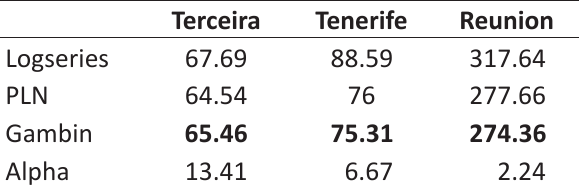
values for the SAD model selection for the Table 2. AIC c three SAD models (logseries, Poisson lognormal-PLN, and gambin) fitted to indigenous woody plants in each island (Terceira, Tenerife, and Reunion). The model comparison was values (“Alpha”) are also shown.